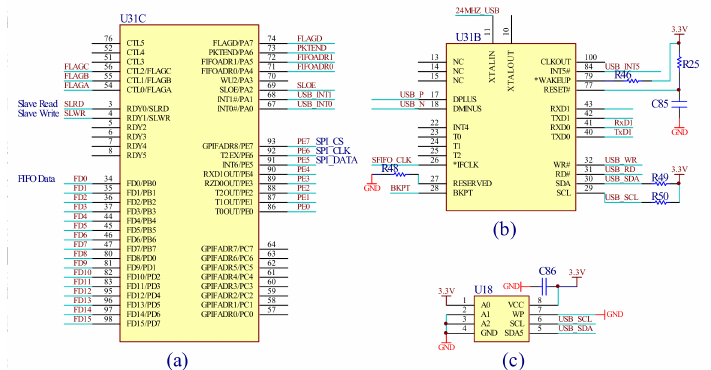
Figure 12. The universal serial bus(USB) interface circuit: ( a ) the main In/Out port of the USB; ( b ) the functional module of the USB and ( c ) the memory chip of the USB for program storage.